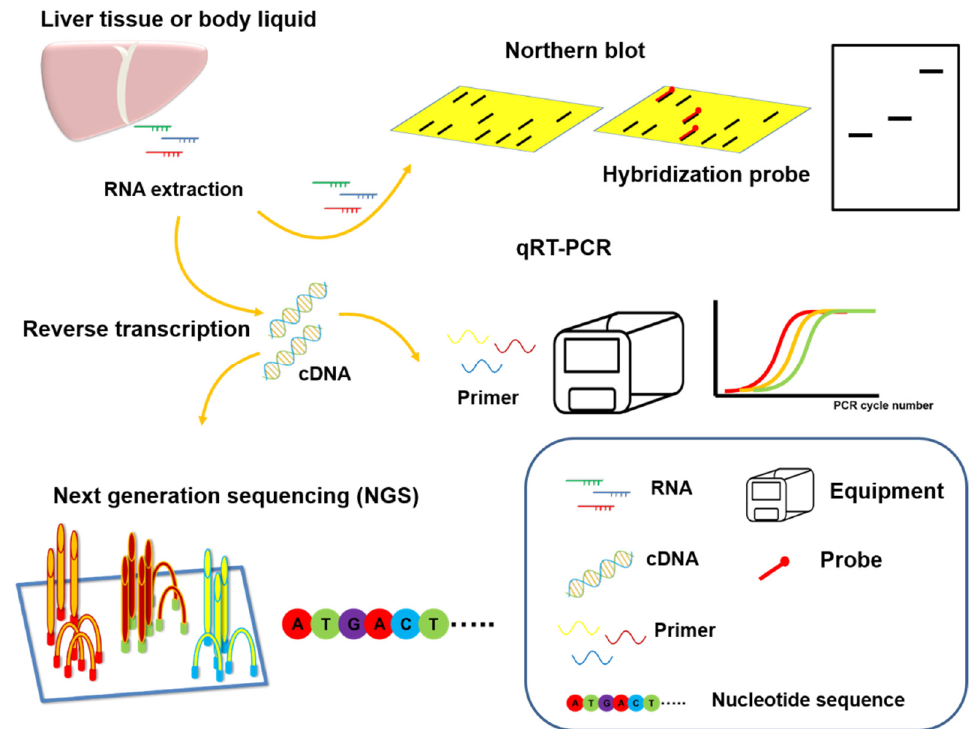
Figure 3. Typical techniques for detecting miRNAs.